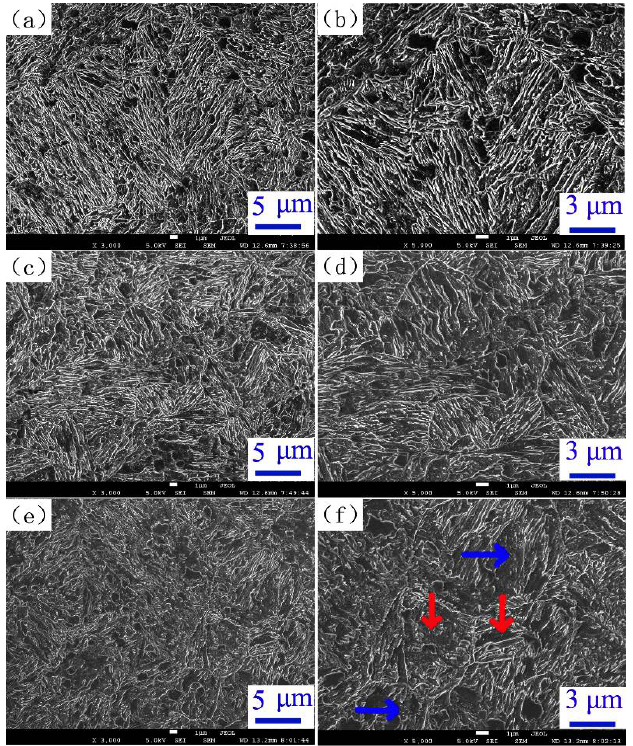
Figure 4. Secondary electron micrographs of the samples quenched to 280 °C and partitioned at 400 °C for ( a , b ) 12 s, ( c , d ) 90 s, and ( e , f ) 600 s.